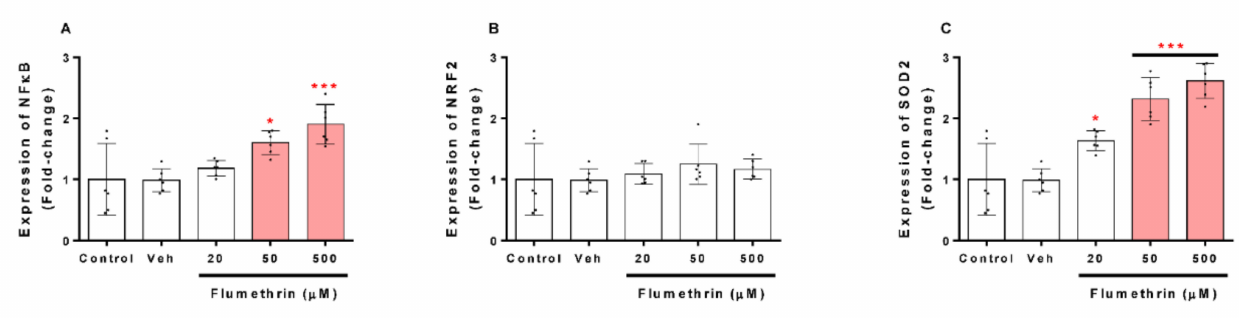
Figure 7. The effect of flumethrin (20, 50, and 500 µ M) in SH-SY5Y cells after a 24 h incubation period on NF κ B ( A ), NRF2 ( B ), and SOD2 ( C ) gene expressions related to oxidative stress and the antioxidant gene transcription. All data were normalized with GAPDH expression and given as relative to control. Data are expressed as fold-change with respect to the control (c). Cells with 0.1% DMSO were the negative control (Veh). Results are presented as the mean ± SD of four replicates. * p < 0.05, *** p < 0.001 compared to